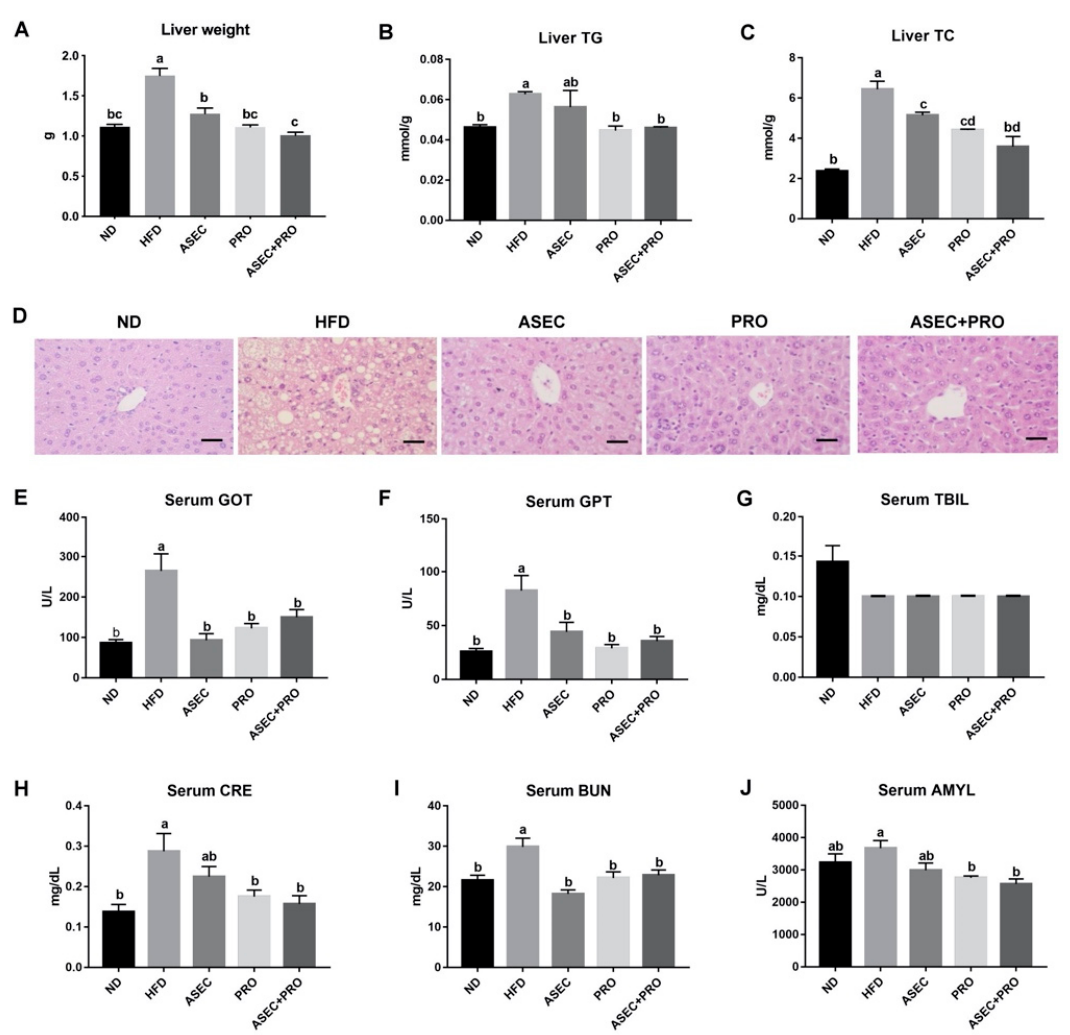
Figure 3. Intervention with ASEC, PRO, or ASEC + PRO alleviated hepatic steatosis. ( A ) Liver weight. ( B ) Liver TG. ( C ) Liver TC. ( D ) H&E staining of the liver biopsy. The scale bar is 100 µm. ( E ) Serum glutamate oxaloacetate aminotransferase (GOT). ( F ) Serum glutamate pyruvate aminotransferase (GPT). ( G ) Serum total bilirubin (TBIL). ( H ) Serum creatinine (CRE). ( I ) Serum blood urea nitrogen (BUN). ( J ) Serum amylase (AMYL). Biochemical characterization was performed using FUJI SRI-CHEM slides and a FUJI DRI-CHEM analyzer. Data ( n = 8) are expressed as the mean ± SEM. Statistical significance ( p < 0.05) is indicated by different letters (e.g., a, b).